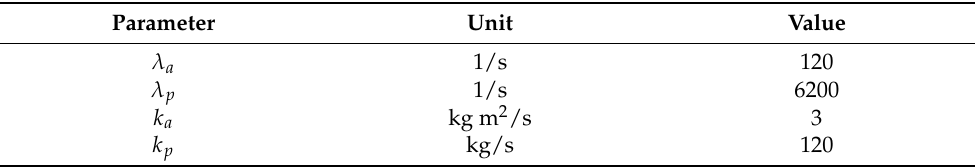
Table 2. Control system parameters applied during simulation and experimental